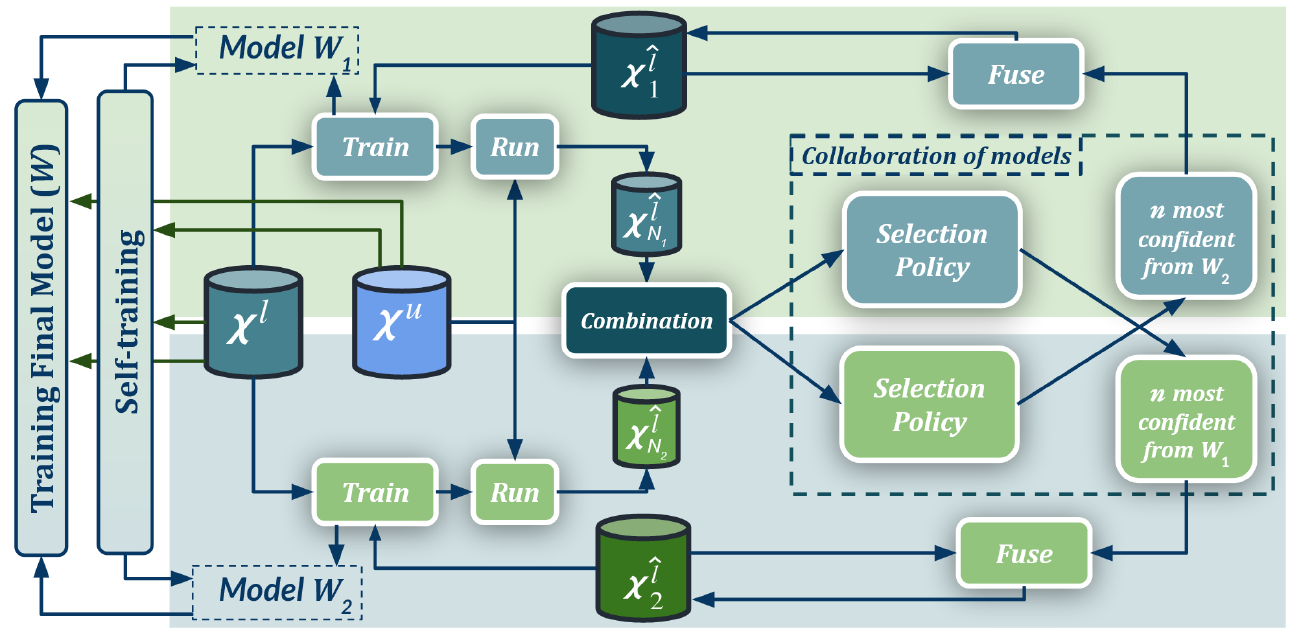
Figure 1. Co-training procedure for UDA. X l is a set of labeled synthetic images, X u a set of unlabeled real-world images, and X ˆ l x is the set x of real-world pseudo-labeled images (automatically generated). Our self-training stage provides two initial domain-adapted models ( W 1 , W 2 ), which are further trained collaboratively by exchanging pseudo-labeled images. Thus, this procedure treats the deep models as black boxes and drives their collaboration at the level of pseudo-labeled target images, i.e., neither modifying loss functions is required, nor explicit feature alignment. See details in Section 3 and Algorithms